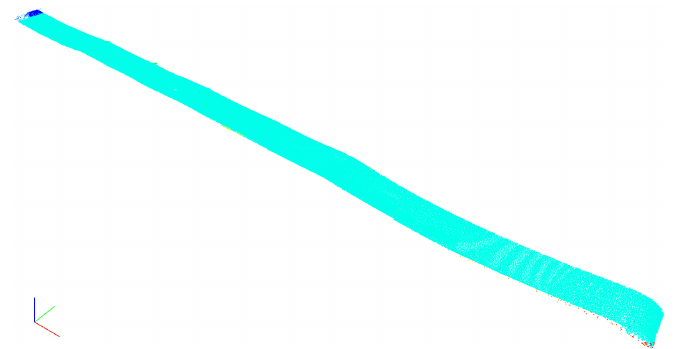
Figure 14. DBSCAN point cloud segmentation (main cluster in